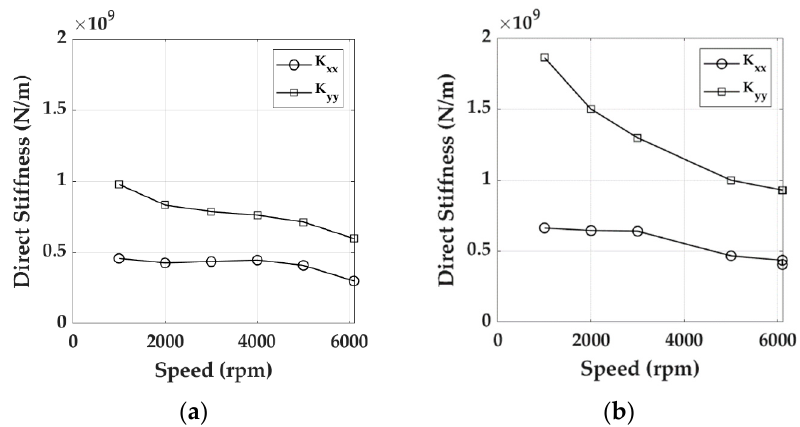
Figure 29. Flooded Rocker Pivot bearing synchronous direct stiffness: ( a ) 1.3 MPa, ( b ) 2.1 MPa.